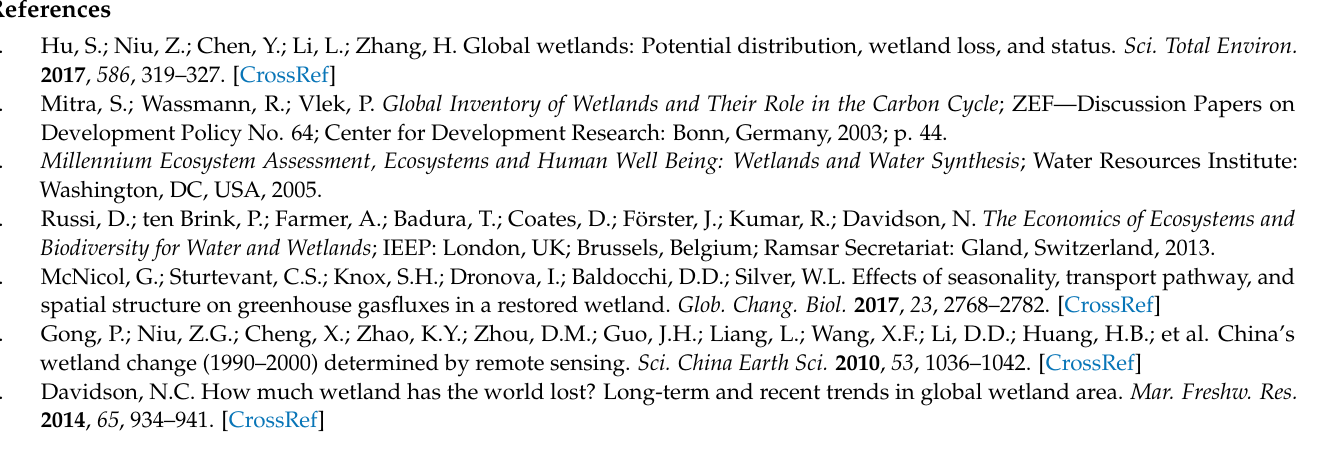
5 species, Figure S2: Number of species in each family of dominant species, Figure S3: Number of species in each family of alien invasive species, Figure S4: Proportions of wetland plant species of different life forms in 28 wetlands, Figure S5: Phylogenetic diversity indices of different species assemblages in 28 wetlands, Figure S6: The mean phylogenetic distance to the nearest taxon for each taxon (MNTD) among species assemblages, visualized by a Principal Coordinates Analysis (PCoA) ordination biplot, Table S1: General information of the 28 wetlands in this study in China, Table S2: Species in the 28